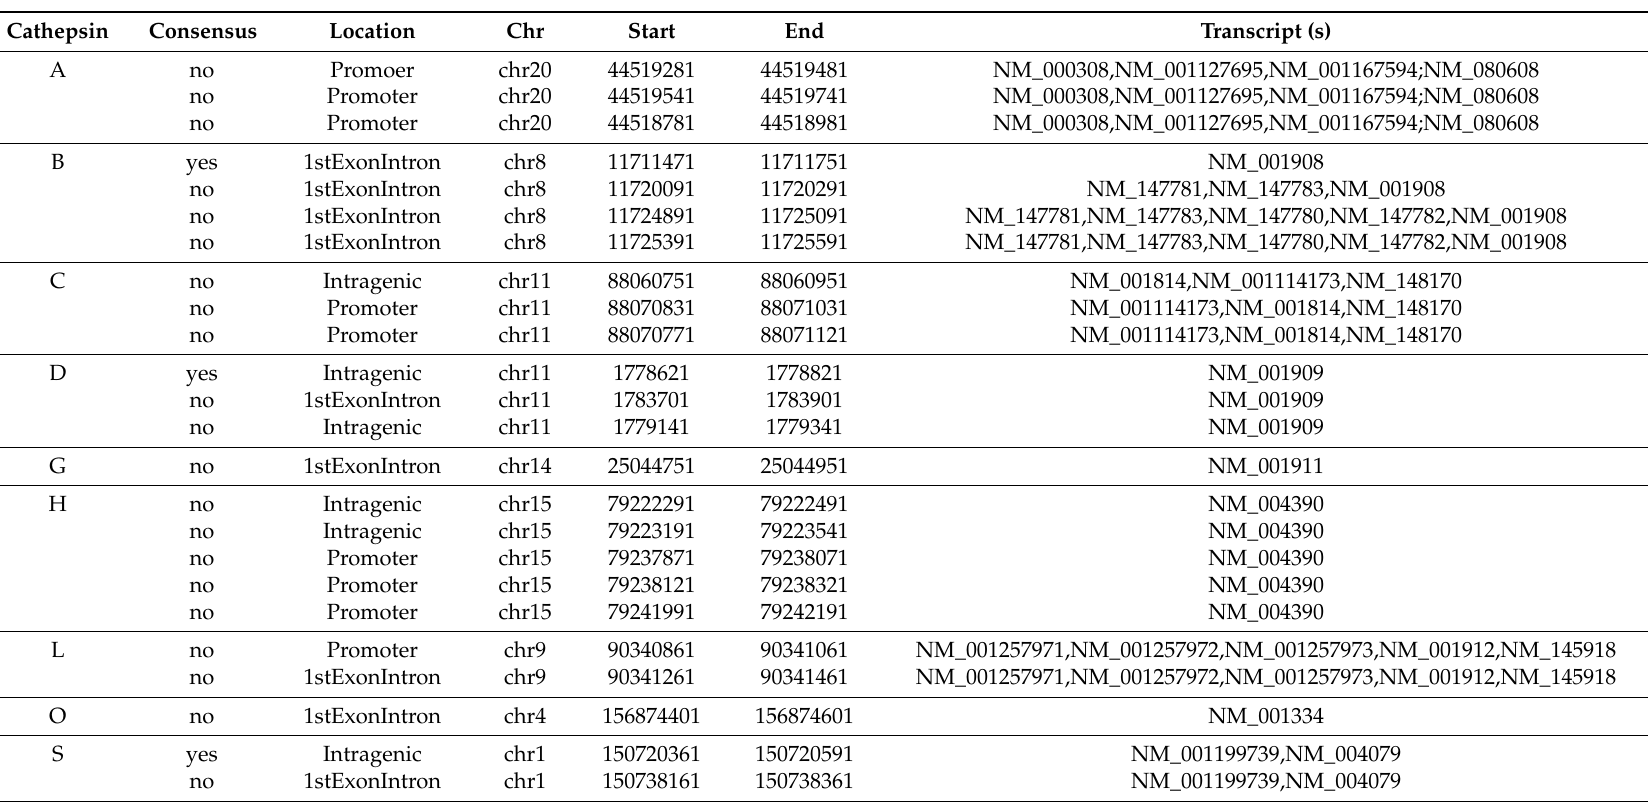
Table 3. Cathepsin genes encode p53 half-sequences. The BAER database was scrutinized and the above cathepsin genes were identified as containing p53 consensus (or non-consensus) binding sequences for activated p53. The chromosomal (Chr) and genetic locations of these sequences are shown, as are the NCBI transcript accession numbers. Results obtained for the negative-controlled binding of p53 (in the absence of activating p53) are shown in blue (based on the availability of